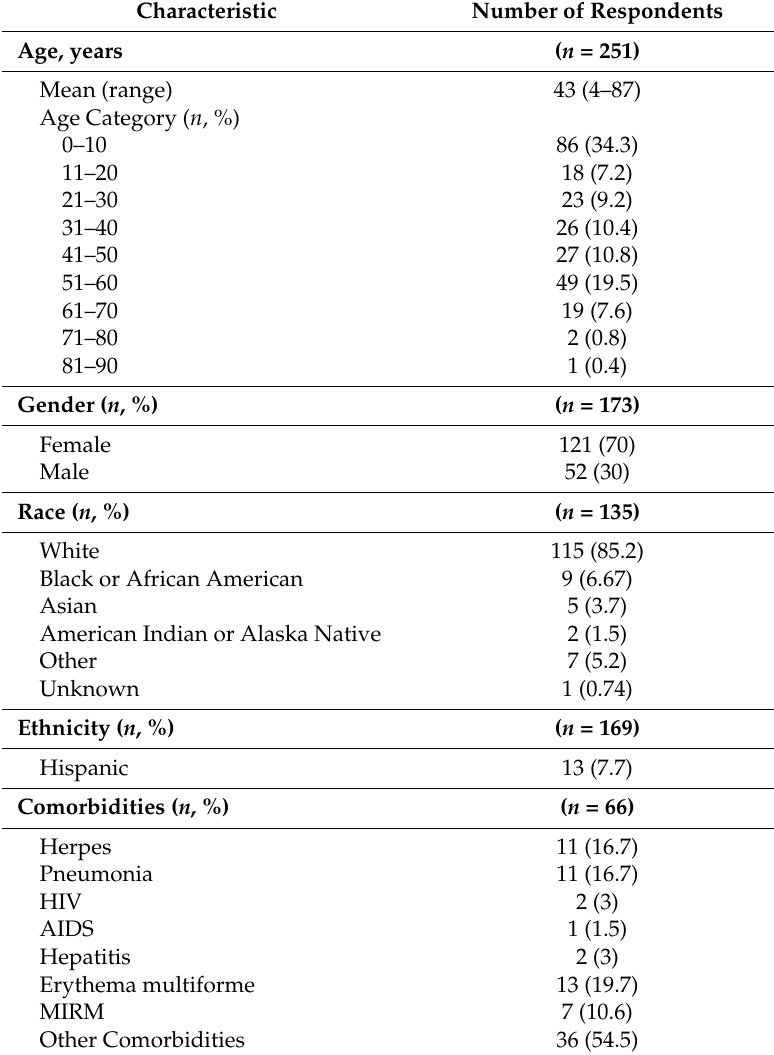
Table 2. Summary of respondent demographics.